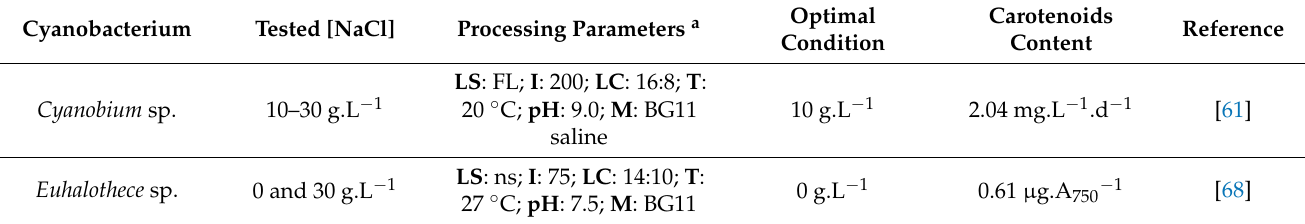
Table 5. Effects of salinity on the production of carotenoids by cyanobacteria. Processing parameters include: light source (LS) and intensity (I), light:dark cycle (LC), (T), pH, and culture media (M). Light intensity is expressed in − 2 .s − 1 unless when another unit is indicated. µ mol photons .m